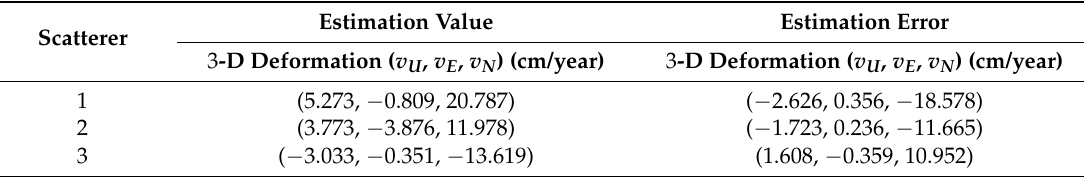
Table 8. Results of 3-D deformation estimations using the motion decomposition